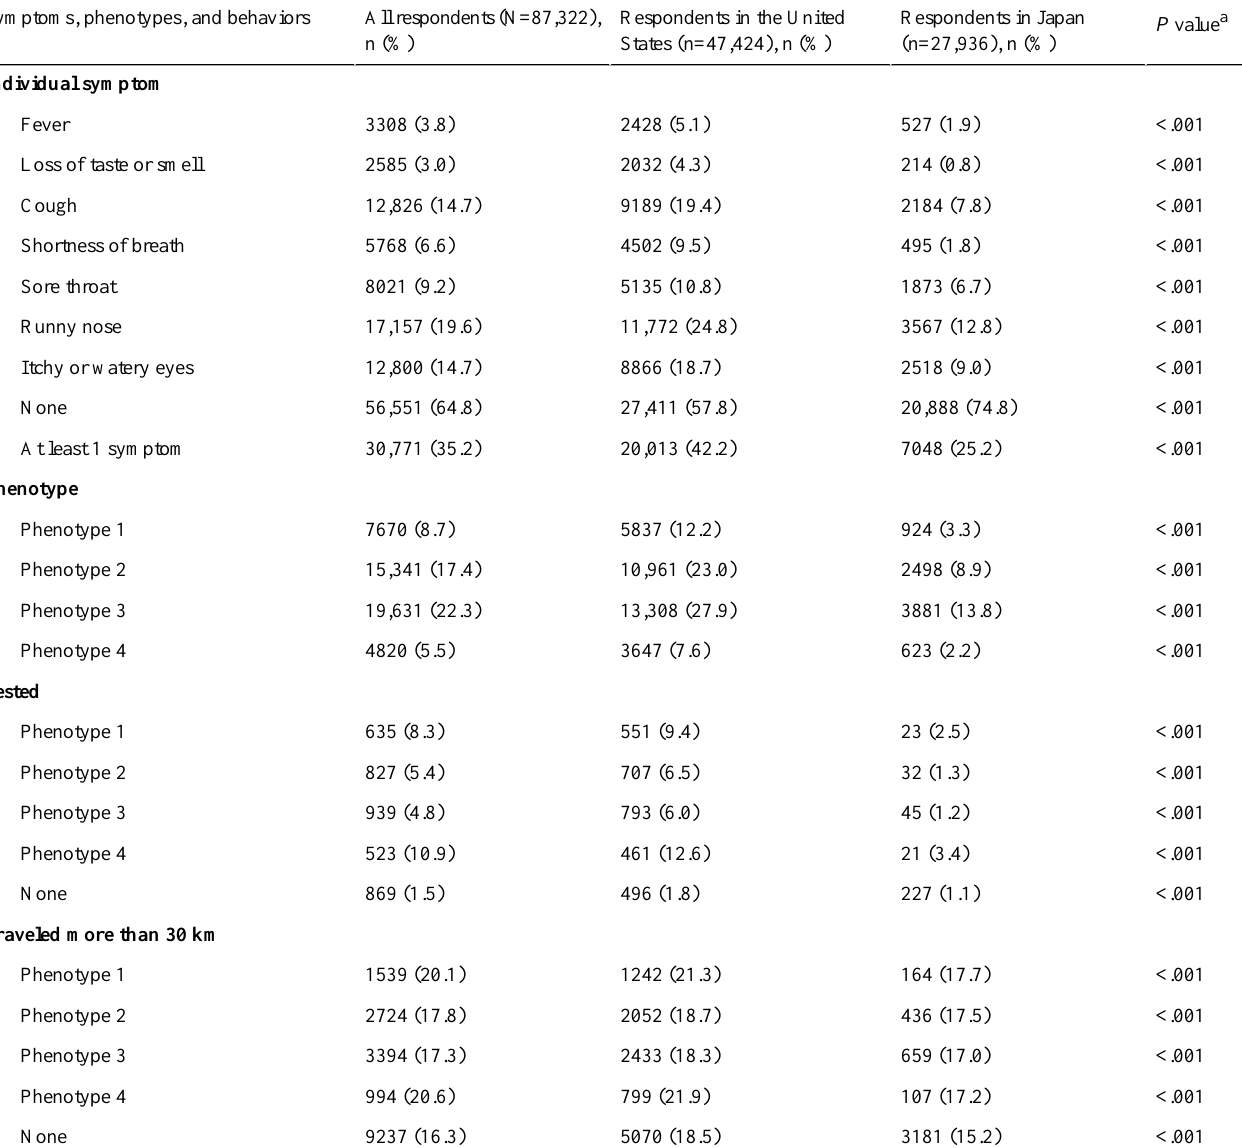
Table 3. Symptoms, phenotypes, and behaviors reported by respondents using a web-based questionnaire recruited through the Microsoft News platform. (%)Symptoms, phenotypes, and